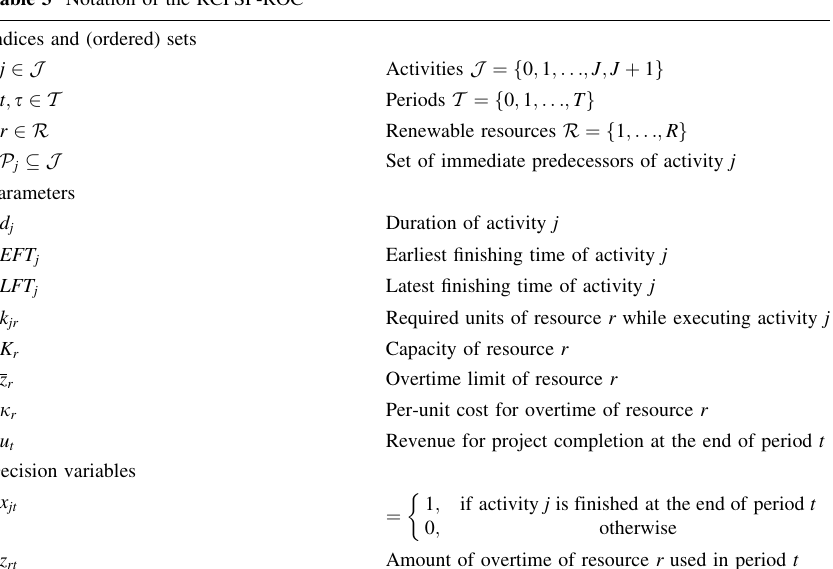
Table 3 Notation of the RCPSP-ROC Indices and (ordered)